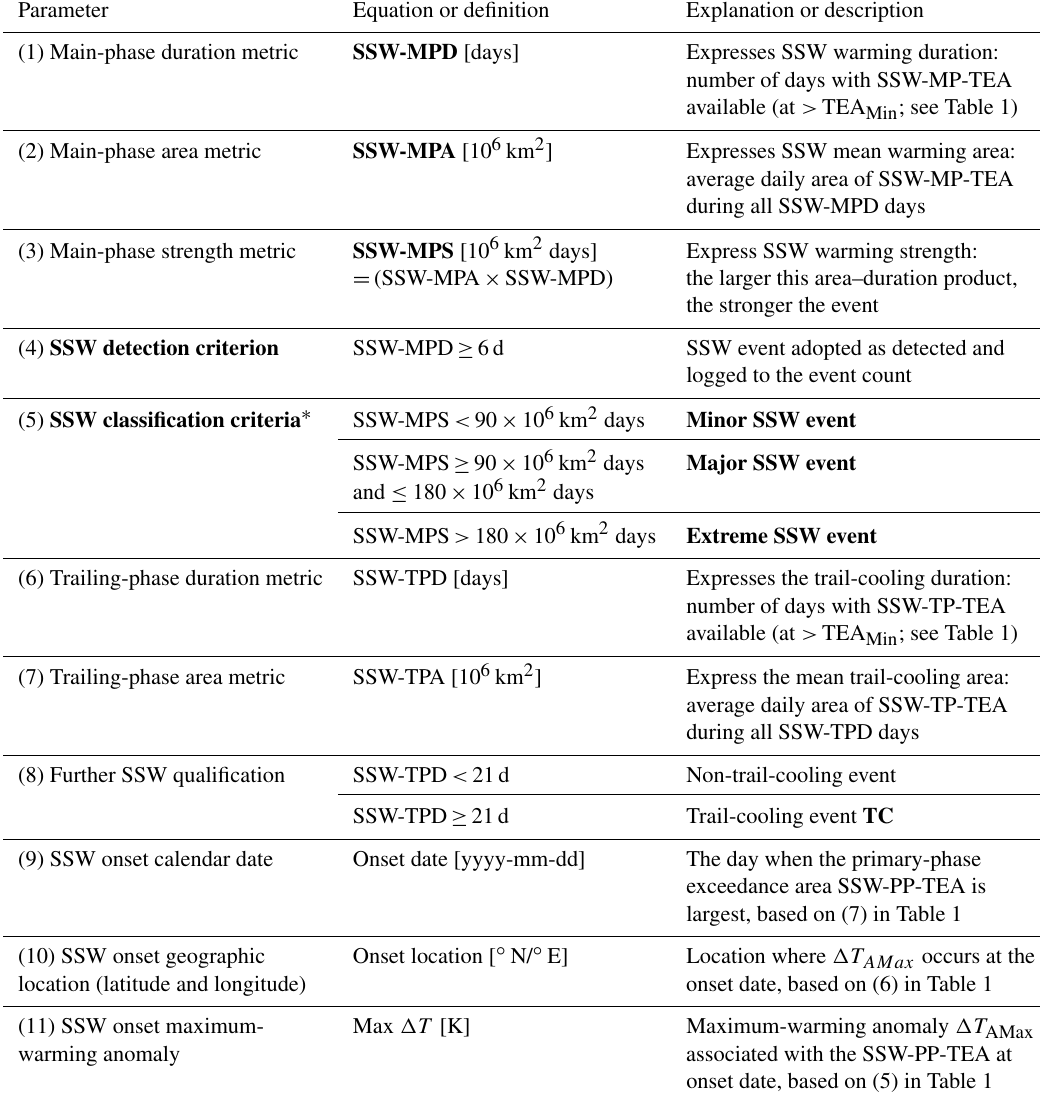
Table 2. Metrics of the new SSW monitoring approach for detection, classification, and further qualification; the boldfaced font in (1)–(5) marks key metrics and criteria for the detection and classification, also shown as main ones in Fig.